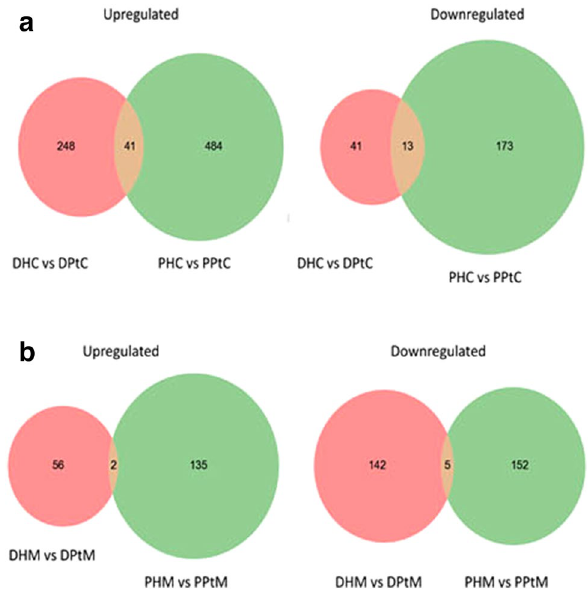
Figure 6. Venn diagrams detailing shared and distinct gene expression among DU145 and PC-3 parent and holoclone cells ( a ) and murine-derived ( b ) samples. ( a ) Forty-one genes were found to be commonly upregulated in holoclones (when compared to their parental counterparts derived from DU145 and PC-3 cells). Thirteen downregulated genes were shared by PC-3 and DU145-derived holoclones (n = 1). DHC DU145 holoclone cells, PHC PC-3 holoclone cells, DPtC DU145 parental cells, PPtC PC-3 parental cells. ( b ) Two genes were found to be commonly upregulated in PC-3 and DU145 holoclone-derived tumours (when compared to those generated by respective parental cells). 5 genes were commonly downregulated in both PC-3 and DU145 holoclone-derived tumours (n = 1). DHM DU145 holoclone murine tumour, PHM PC-3 holoclone murine tumour, DPtM DU145 parental murine tumour, PPtM PC-3 parental murine